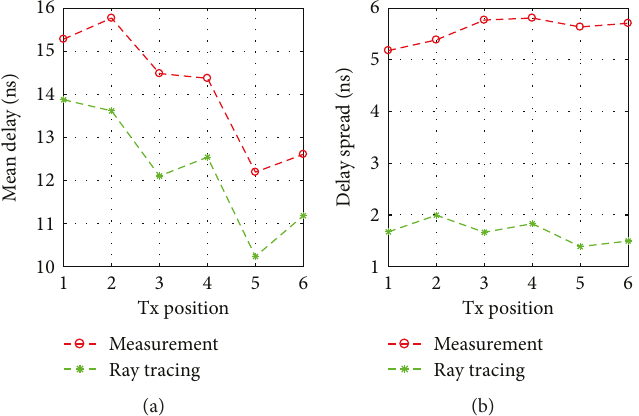
Figure 20: Measured and RT-simulated mean delays (a) and delay spread (b) for all Tx positions in the o ffi ce LOS scenario.